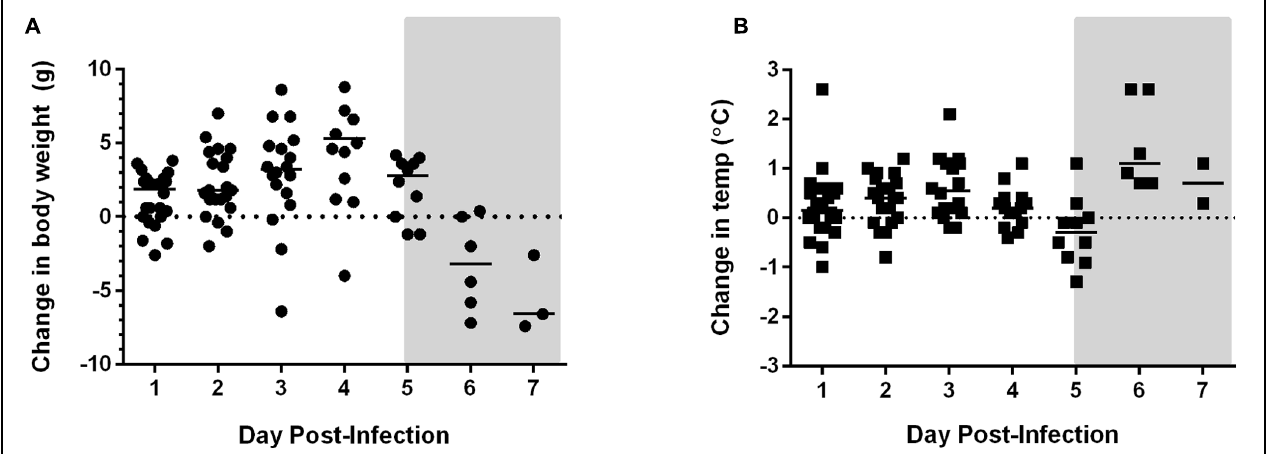
FIGURE 1 | Weight loss and temperature changes in Rift Valley fever virus (RVFV)-infected Lewis rats. Changes in (A) body weight, (B) temperature over the duration of the experiment. The gray shaded box on both graphs represents the window of clinical disease (5–7 dpi).